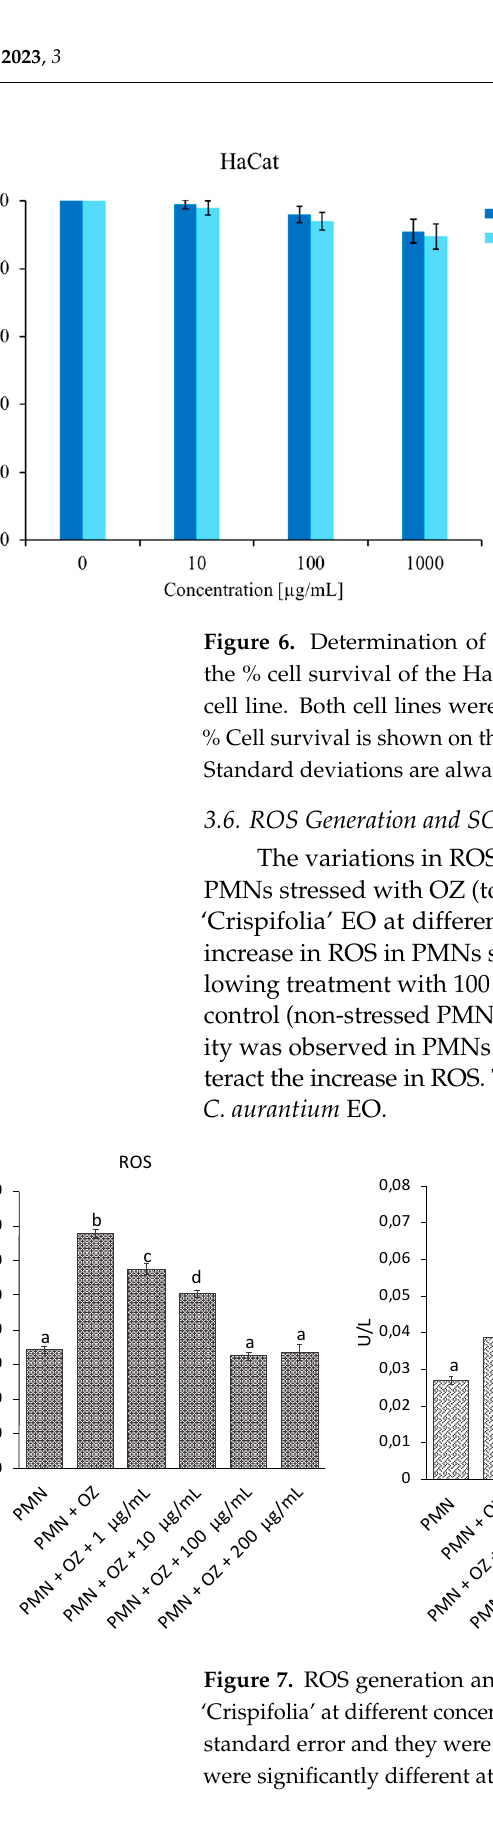
Figure 7. ROS generation and SOD and CAT activities in PMNs treated with EO of C. aurantium ‘Crispifolia’ at different concentrations (x-axis) with or without OZ. Data were presented as mean and standard error and they were analyzed with a paired t-test. Bars not accompanied by the same letter were significantly different at p < 0.05. 4. Conclusions The EO of C. aurantium ‘Crispifolia’ was characterized by a high amount of the monoterpene hydrocarbon limonene (33.35%), but also by the presence of several oxygenated monoterpenes, such as bergamol (6.77%), neryl acetate (6.28%), geranyl acetate (10.12%), α -terpineol (7.06%), and β -linalool (7.69%).